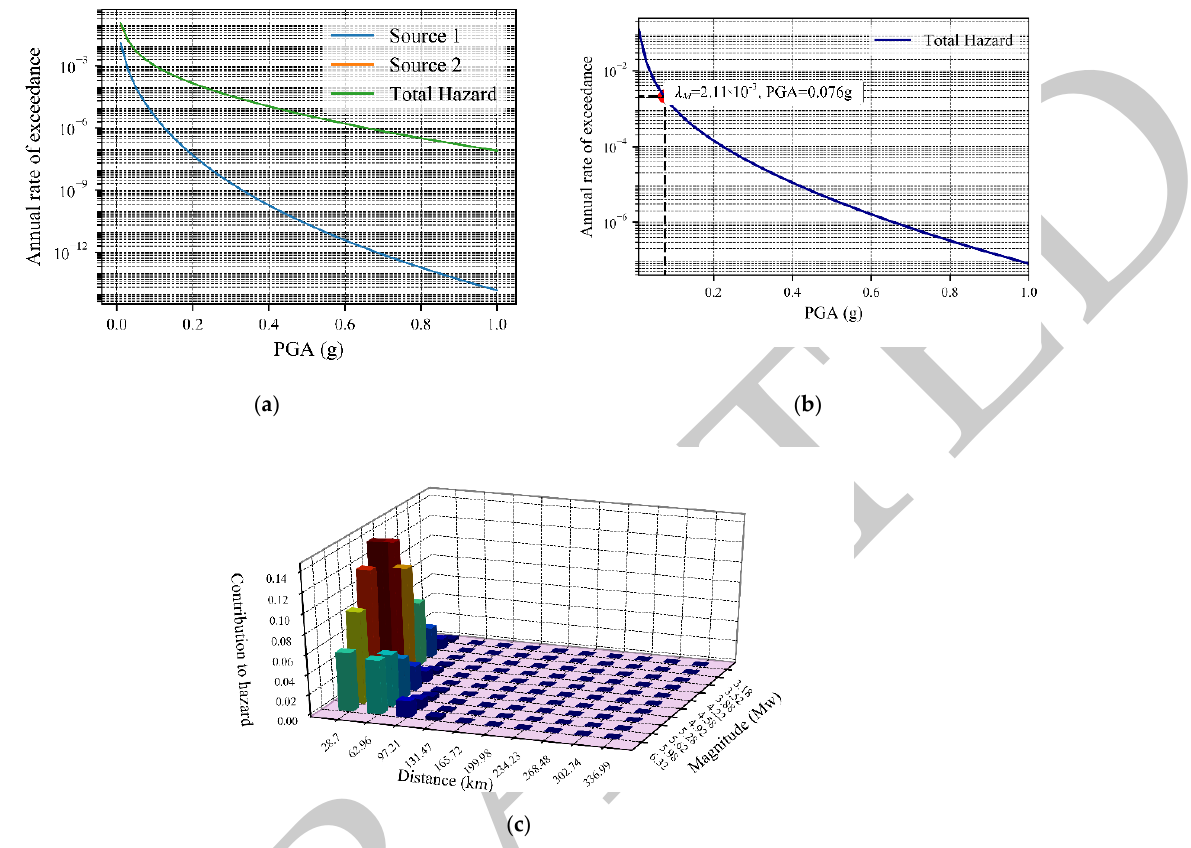
Figure 19. ( a ) Seismic hazard curve for all sources along with total hazard curve, ( b ) Total hazard curve showing the annual rate of exceedance to the corresponding 475 returned period (T R ), ( c ) Deaggregation of PGA with 475 years T R for RS2.